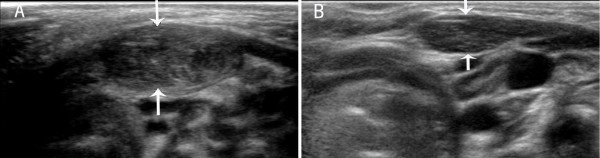
A. Cross-section of the sternocleidomastoid muscle (SCM) in a patient with early-stage muscular torticollis. B. Cross-section of the SCM of the normal side. Thickening of the affected SCM is apparent, and there are hypoechoic signals with a clear boundary and disappearance of the inner muscle texture.